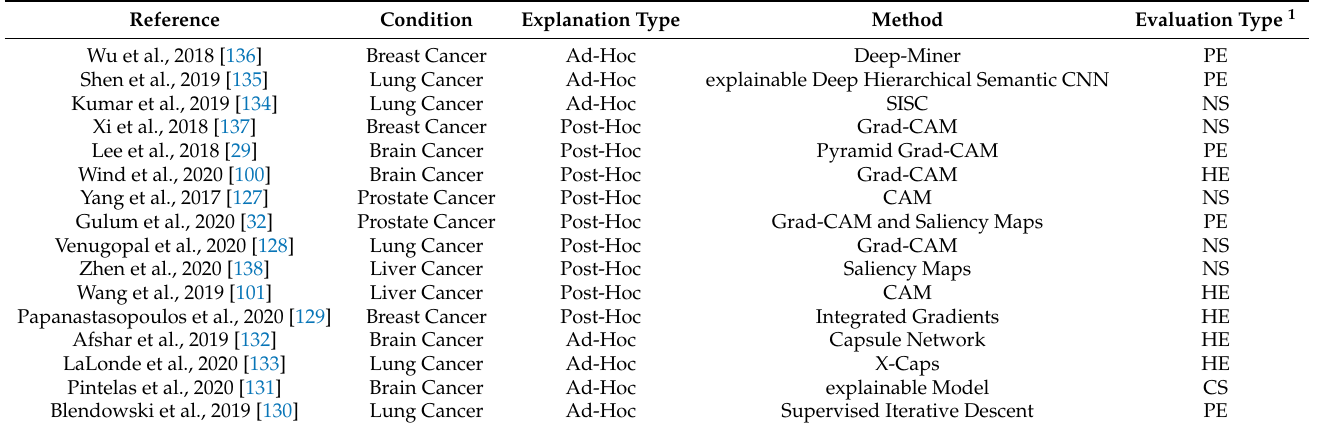
Table 2. Explanation Techniques for Deep Learning Cancer